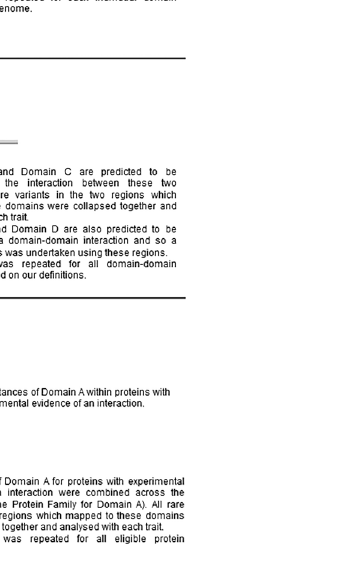
Fig 1. Graphical summary of how rare variants within domain regions were collapsed together for analysis. This figure describes how regions of rare variants were collapsed together and analysed: (cid:129) Individual Domains: Regions which mapped to individual domains of a protein were analysed as opposed to the conventional approach of using individual gene regions. (cid:129) Domain-Domain Interactions: Pairwise regions which mapped to two domains predicted to be responsible for a domain-domain interaction were analysed together. (cid:129) Protein Families: All regions which mapped to the same type of protein domain within proteins which had experimental evidence of interaction were combined and analysed together. Domain images were created using the generate graphics feature from Pfam (located at http://pfam.xfam.org/generate_graphic).